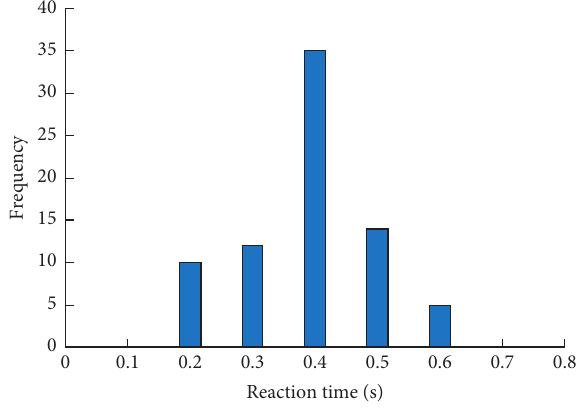
Figure 6: Reaction time histogram.